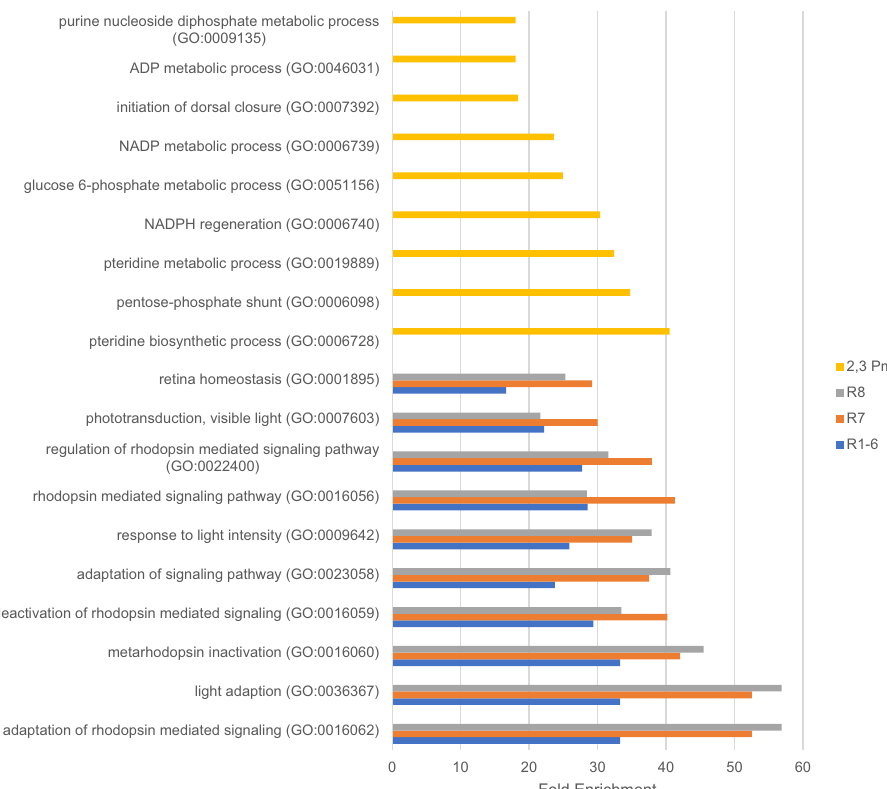
Fig. 8 Top enriched Gene Ontology terms for photoreceptor and pigment cell marker genes are related to light reception and pigment production, respectively. Bar graphs showing the fold enrichment of the top ten enriched Gene Ontology (GO) terms for pooled marker genes from 1-day, 3-day, and 7-day-old adult eyes for secondary and tertiary pigment cells (2,3 Pm) and R1-6, R7, and R8